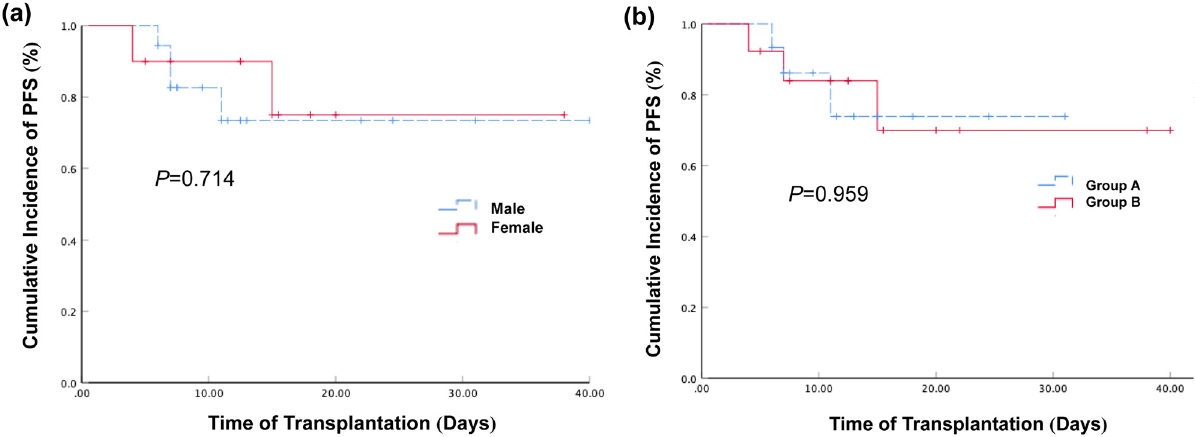
Figure 5: E ff ect of gender and age of LOHC patients on the cumulative incidence of PFS. ( a ) The cumulative incidence of PFS in male LOHC and female LOHC patients after haplo - PBSCT were 73.5% ( 95% CI: 50.2 – 96.8% ) and 75% ( 95% CI: 44.1 – 105.9% ) , respectively. The P value was 0.714. ( b ) The cumulative incidence of PFS in LOHC onset age younger than 27 years old and LOHC onset age older than 27 years old after haplo - PBSCT were 73.8% ( 95% CI: 46.8 – 100.8% ) and 69.9% ( 95% CI: 39.52 – 100.28% ) , respectively. The P value was